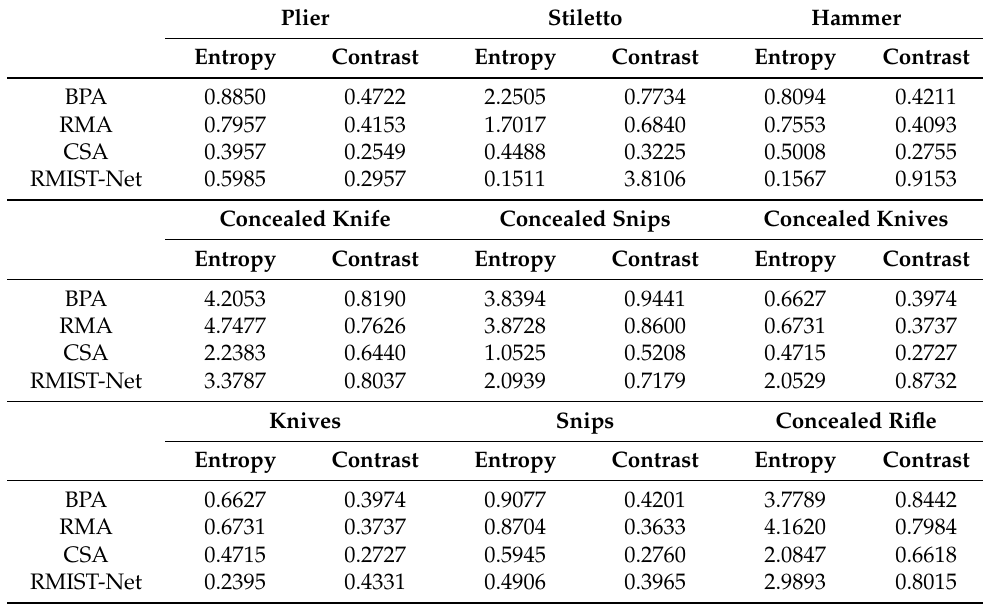
Table 5. Quality evaluation of imaging results of different targets in different algorithms. Plier Stiletto Hammer Entropy Contrast Entropy Contrast Entropy